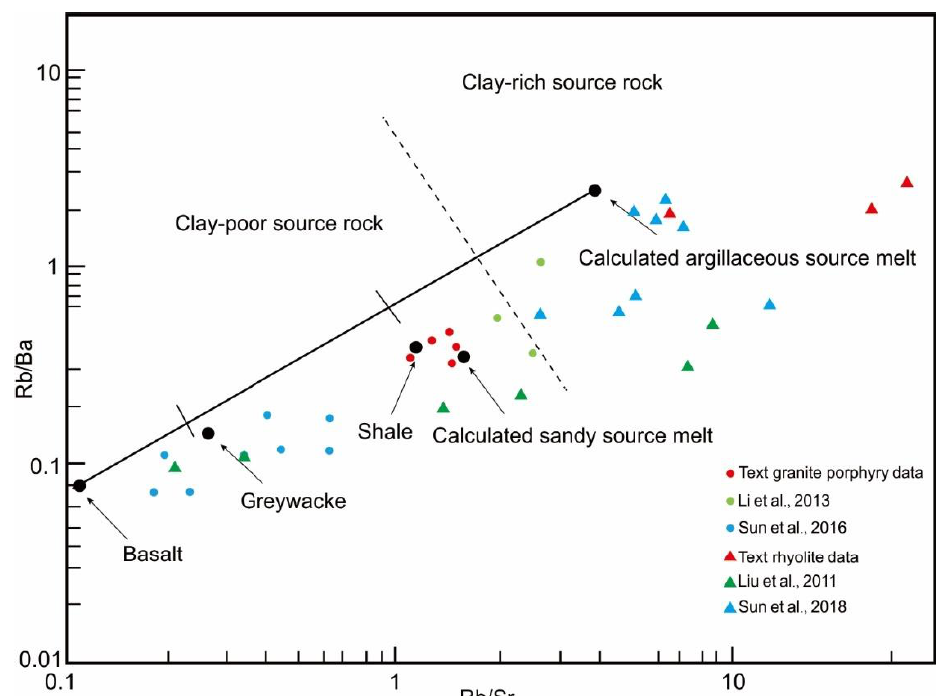
Figure 9. Rb/Ba vs. Rb/Sr diagram for magmatic rocks (base image according to [76]). The samples from Li et al. [17] and Sun et al. [44] are granite porphyries not far from the study area along the Ailaoshan orogenic belt. The samples from Liu et al. [54] and Sun et al. [43] are volcanic rocks not far from the study area along the Ailaoshan orogenic belt.